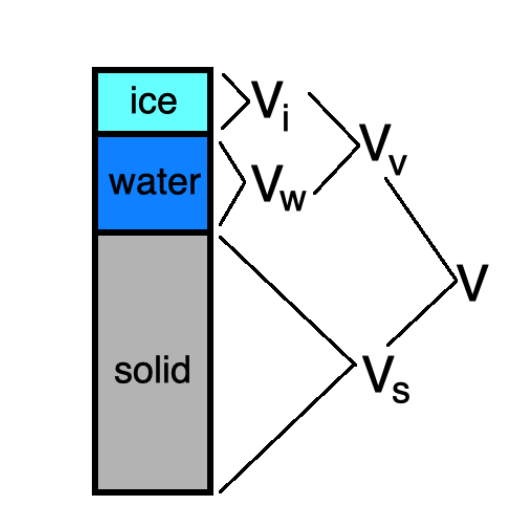
Figure 1. Scheme of porous media volumes, V w + V i = V v and V w + V i + V v = V